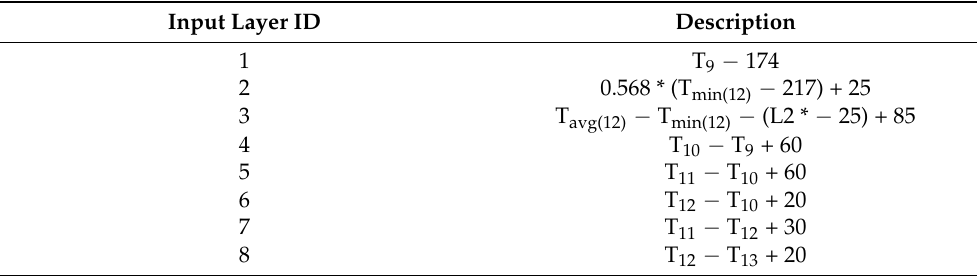
Table 4. Infrared brightness temperature characteristics. The number in subscripts refers to the channel used, T min refers to the 5 × 5 minimum of the channel, and T avg refers to the 5 × 5 average of the